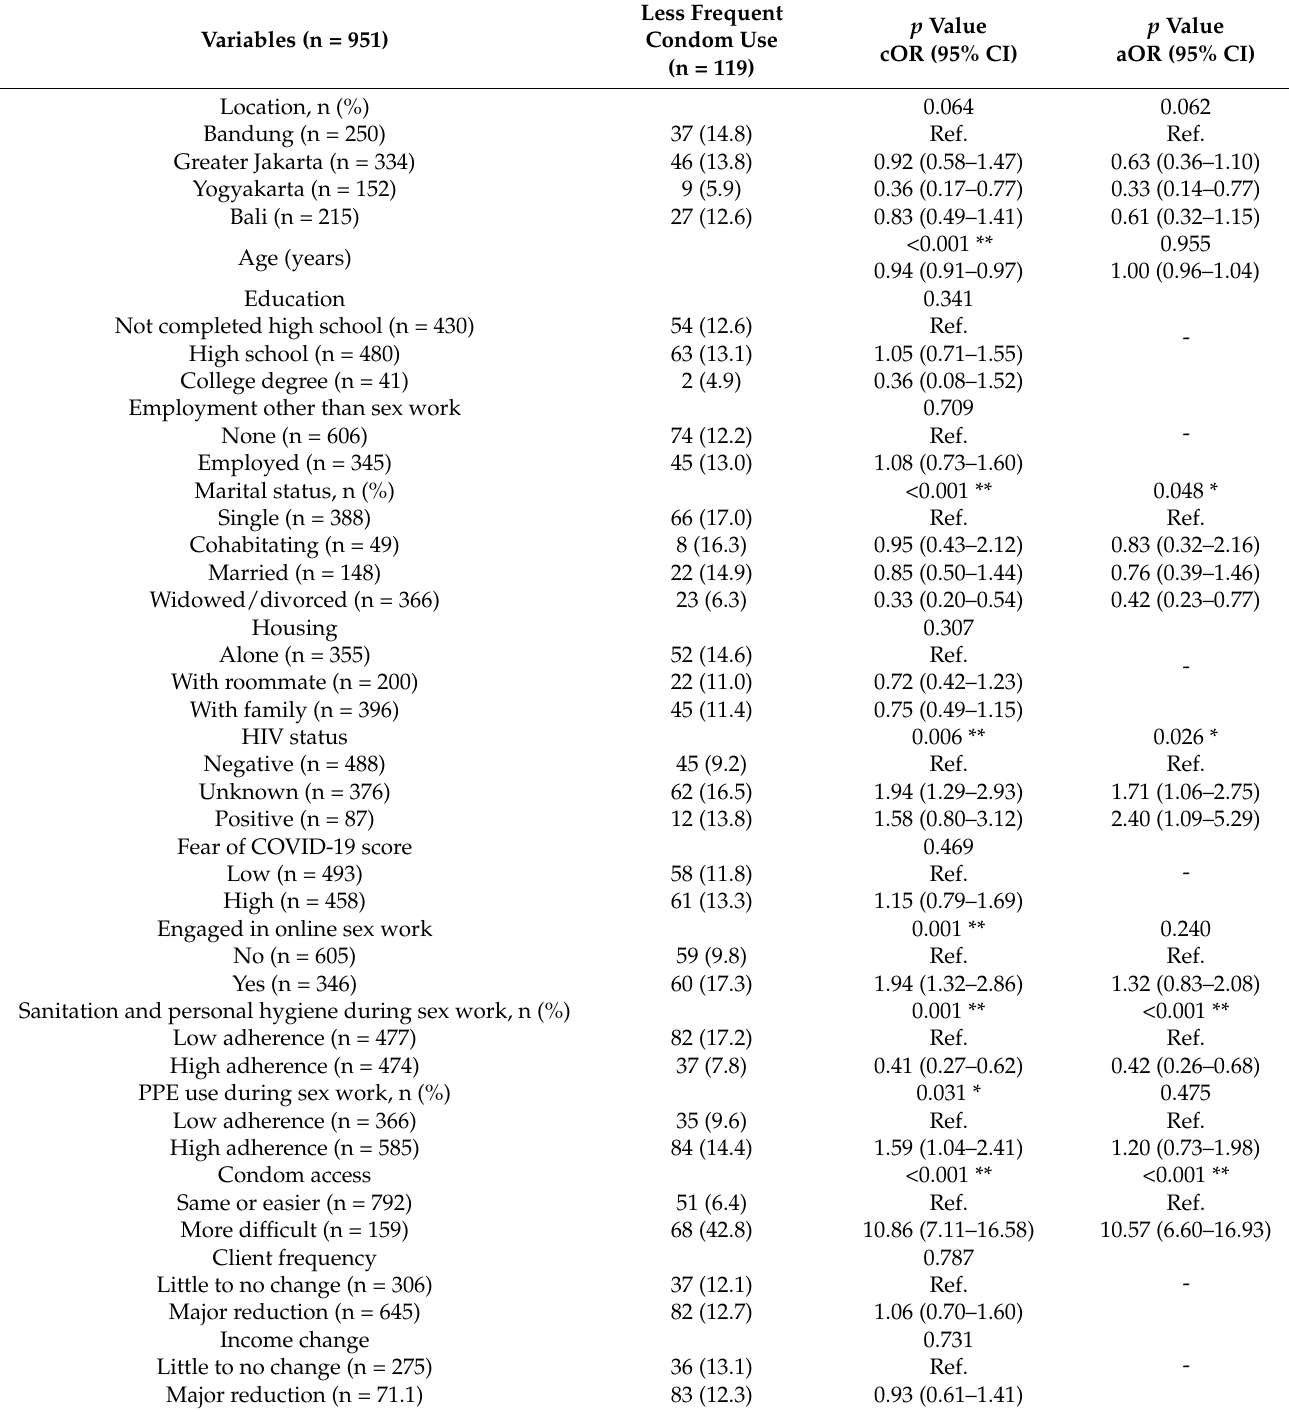
Table 5. Risk factors for less frequent condom use during COVID-19